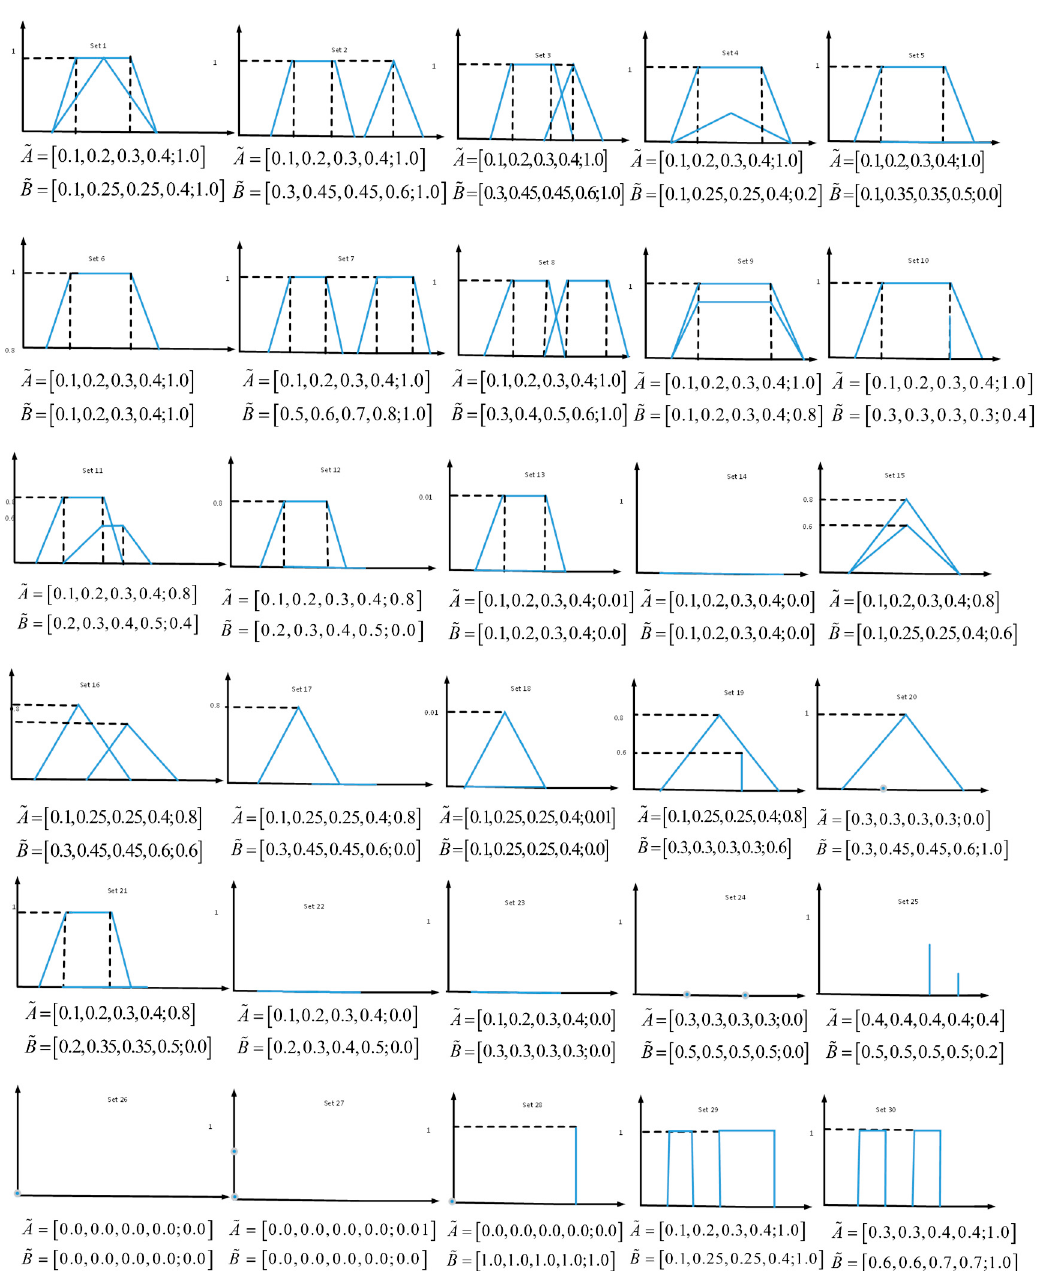
Figure 2. Graphical representation of 30 different sets of general type-2 fuzzy numbers Table 1. Comparative analysis of the calculation results.